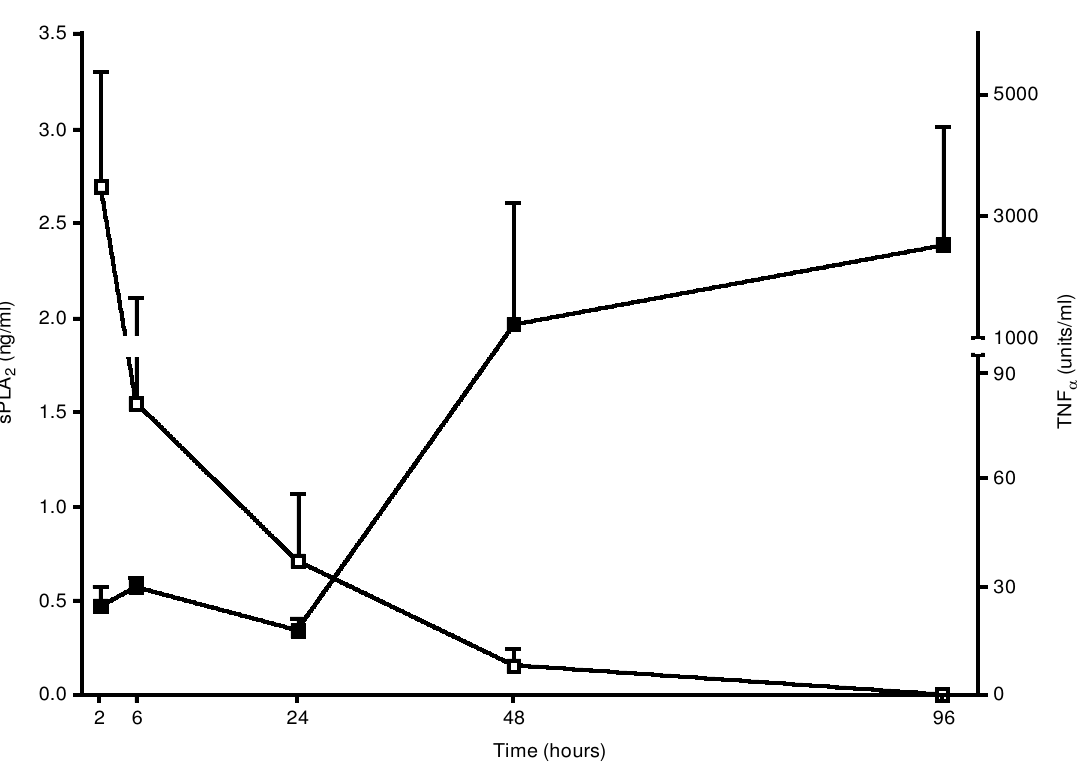
FIG. 2. Time course of sPLA 2 ( j ; n = 4 ± 6) and TNF a ( u ; n = 3 ± 7) levels in the cell-free pleural washing following LPS (100 m g / cavity)